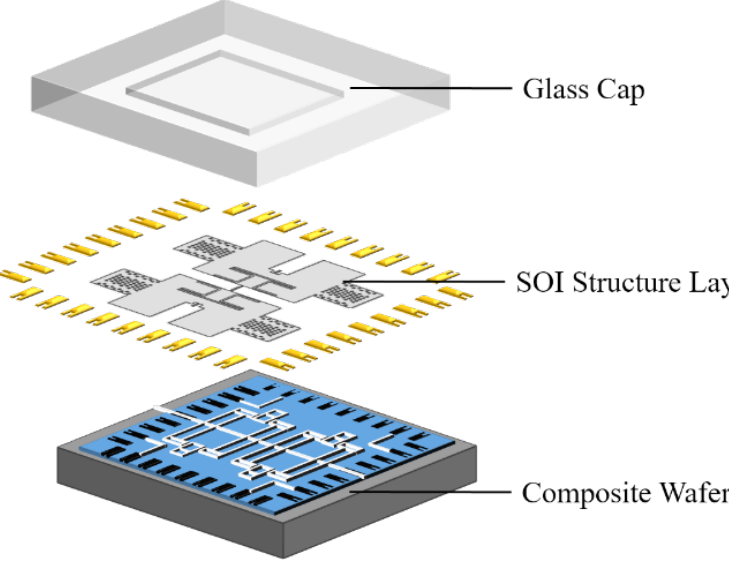
Figure 4. 3D “sandwich structure” wafer -level-packaged BFVG.